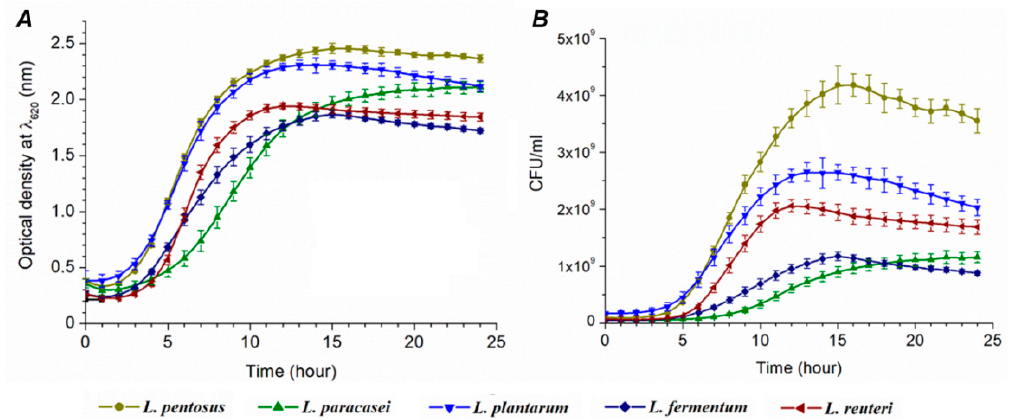
Figure 1. Pure cultures of LAB cells (light microscope, magnification 1000×).